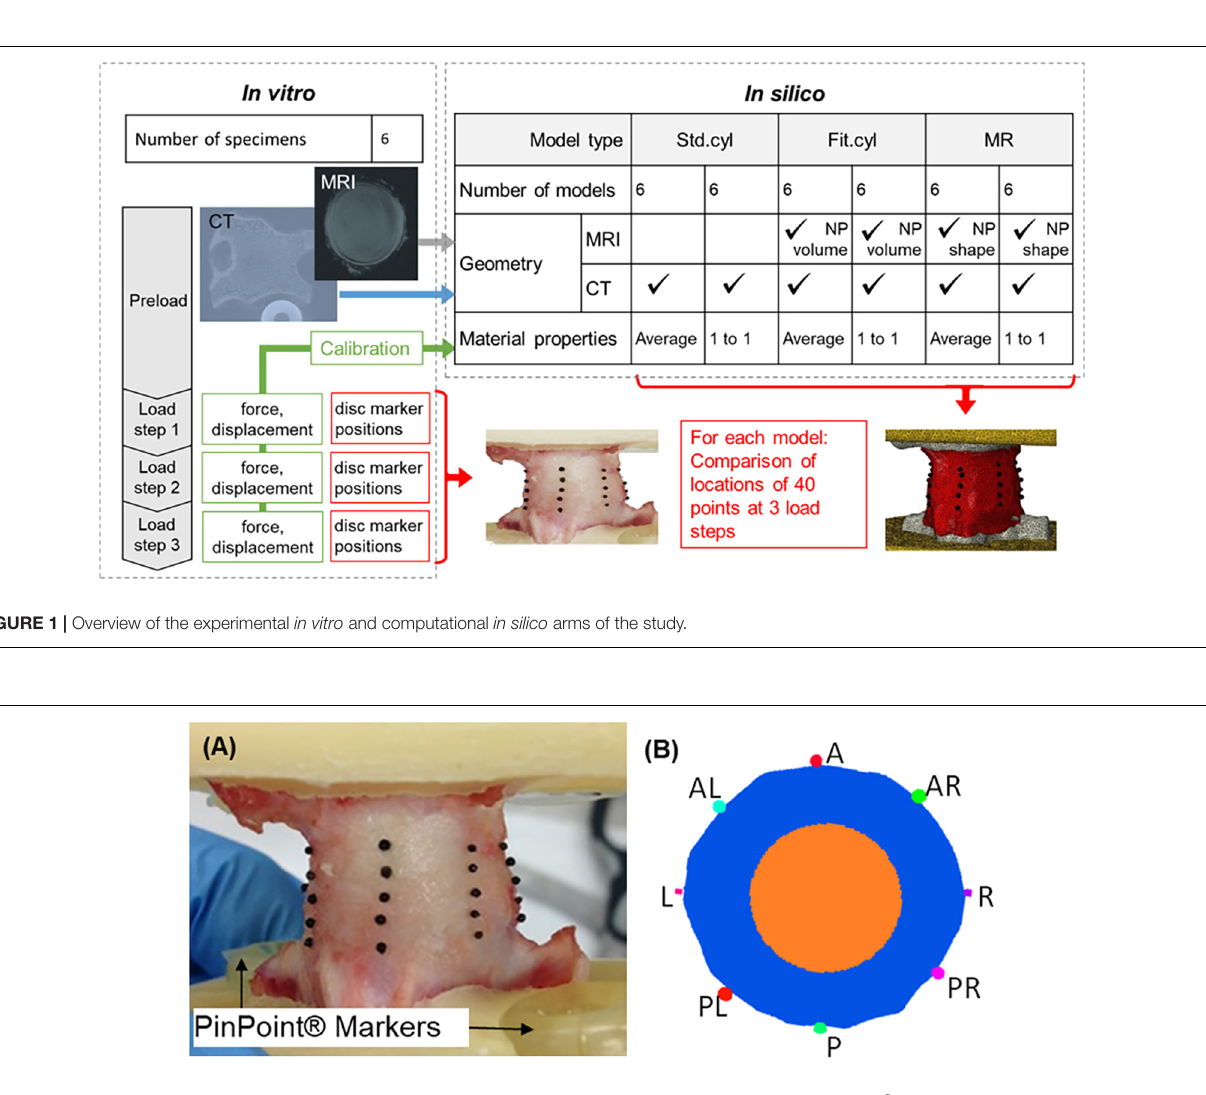
FIGURE 2 | (A) Osteodisc prepared for mechanical testing, with glass fiducial markers, CT- and MR-compatible PinPoint R (cid:13) markers, and PMMA endcaps. (B) Transverse plane slice through the intervertebral disc showing segmentation of the annulus fibrosus (blue), nucleus pulpous (orange) and fiducial glass beads, with classification of the eight zones of the disc (A, anterior; P, posterior; L, left; R, right).